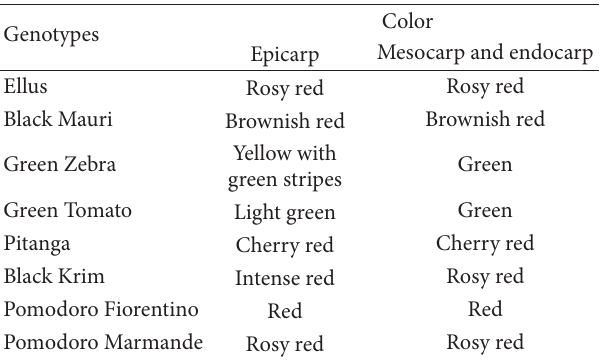
Table 3: Epicarp, mesocarp, and endocarp color of fruits from eight tomato